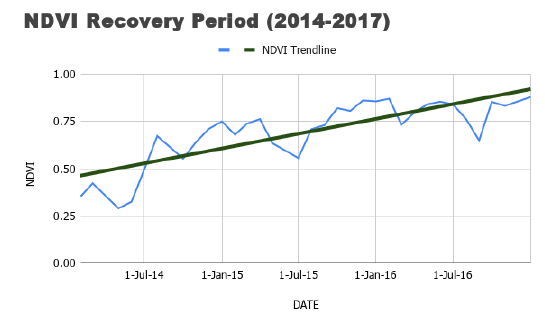
Figure 5. 2013 to Early 2014 NDVI Time Series Chart (Damaged Period)